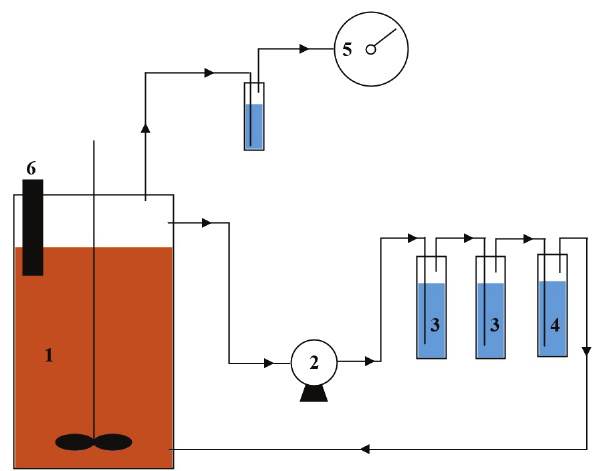
Fig. 1 – Scheme of CSTR reactor with external ammonia re- moval: 1 – CSTR reactor, 2 – peristaltic pump, 3 – gas washing